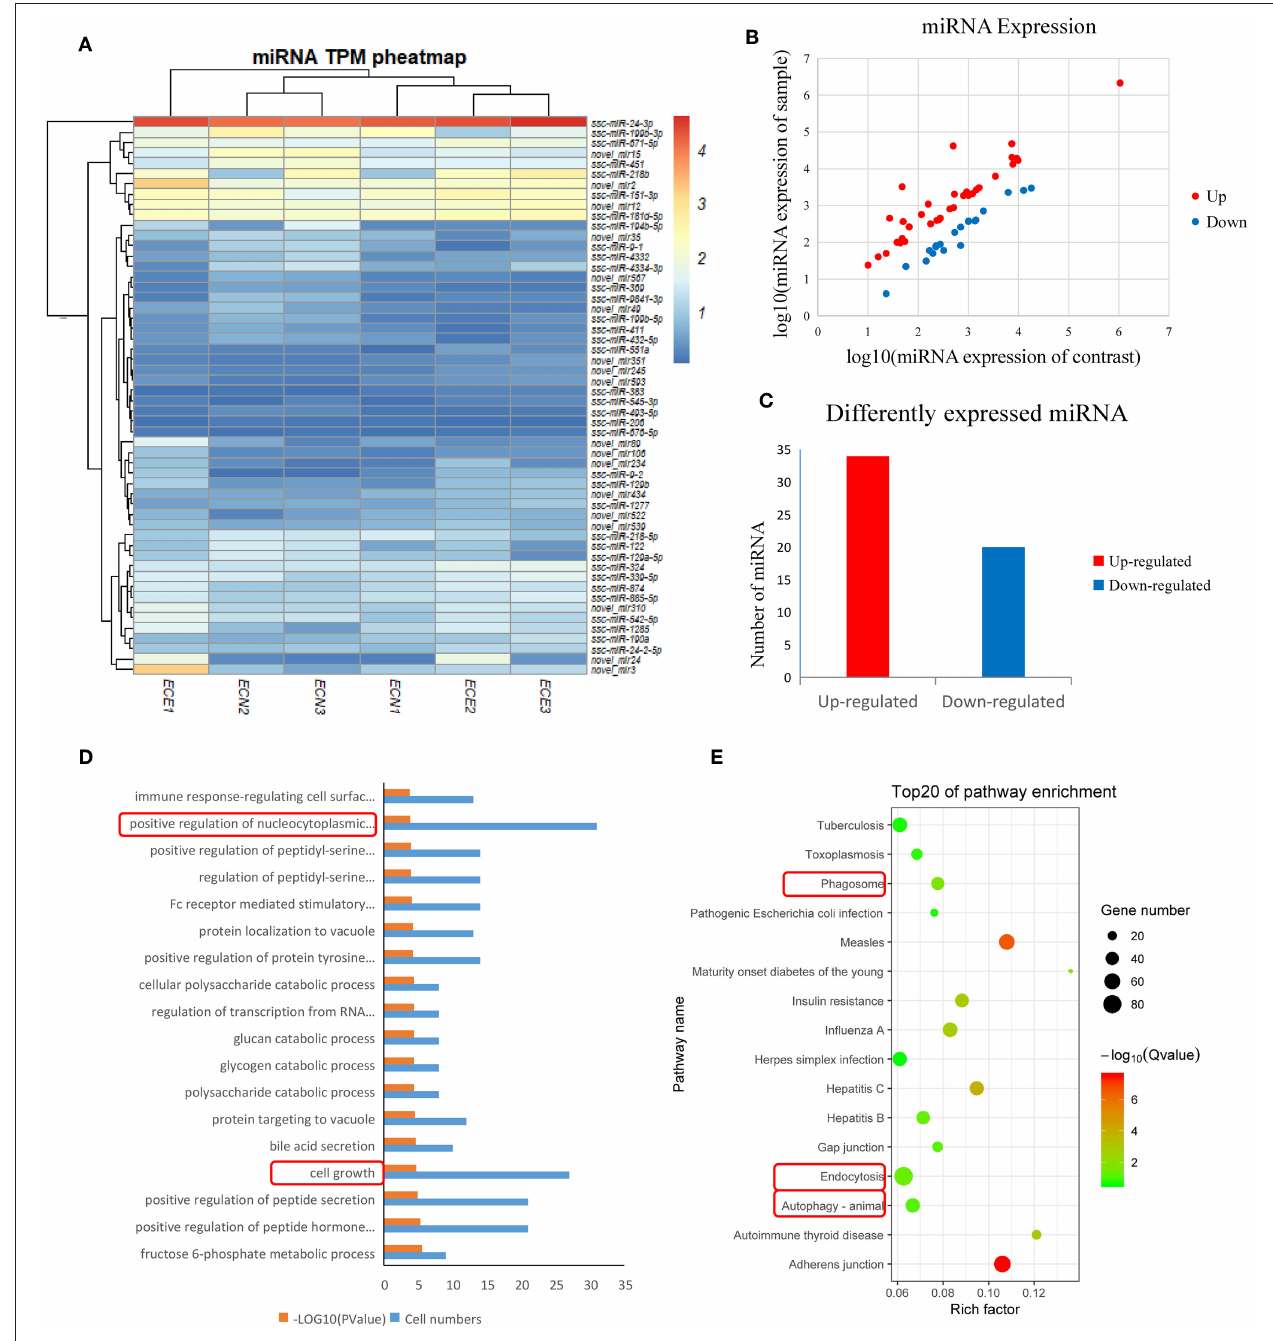
FIGURE 2 | Screening and enrichment analysis of differently expressed miRNA (DEmiRNA) in PRRSV-infected PECs compared with non-infected PECs. (A) Hierarchical clustering analysis (heatmap) for DEmiRNAs using Pearson’s correlation. (B) DEmiRNA expression level analysis by scatter plot. The red spots in this figure represent up-regulated miRNAs, the blue spots represent down-regulated miRNAs. (C) Detailed analysis on the up-/down-regulated DEmiRNAs. Thirty-four up-regulated miRNAs and 20 down-regulated miRNAs were shown. (D) The first 20 GO terms analysis ( P < 0.005) of DEmiRNAs in biological processes. The red textbox in the figure indicates the main processes that related into cells grow and apoptosis. A –log 10 ( P -value) > 2 was considered as significantly different. (E) KEGG signal pathway enrichment analysis of DEmiRNAs ( P < 0.01). The pathways labeled with red textbox were important pathways that are related to cells apoptosis.